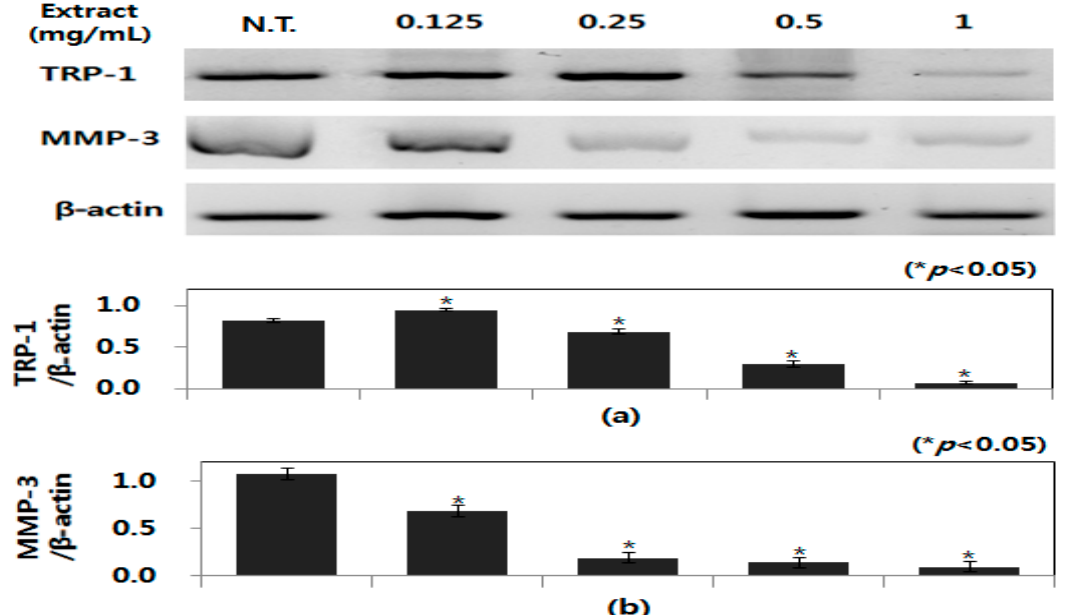
Figure 6. Effect of peanut shell extract on the expression of TRP-1 and MMP-3 mRNA. B16-F0 cells were treated with various concentrations of peanut shell extract for 24 h. The mRNA levels of MMP-9 and TRP-1 were measured using RT-PCR ( a ). Band intensities were estimated using Quantity One software and normalized to β -actin (* p < 0.05). All data are expressed as mean ± SD of three separate experiments performed in triplicate. N.T = not treated sample, Quantification of TRP-1 mRNA expression ( a ), quantification of MMP-3 mRNA expression ( b ).